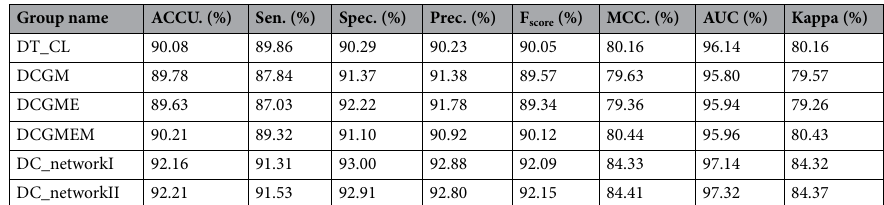
Table 1. The overall results of the performance on six groups of